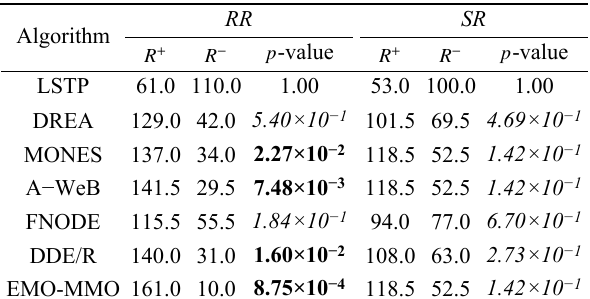
Table 11 Results obtained by the Wilcoxon test for LSTP, DREA, MONES, A-WeB, FNODE, DDE/R, and EMO-MMO in terms of RR and SR compared with ERLDE.